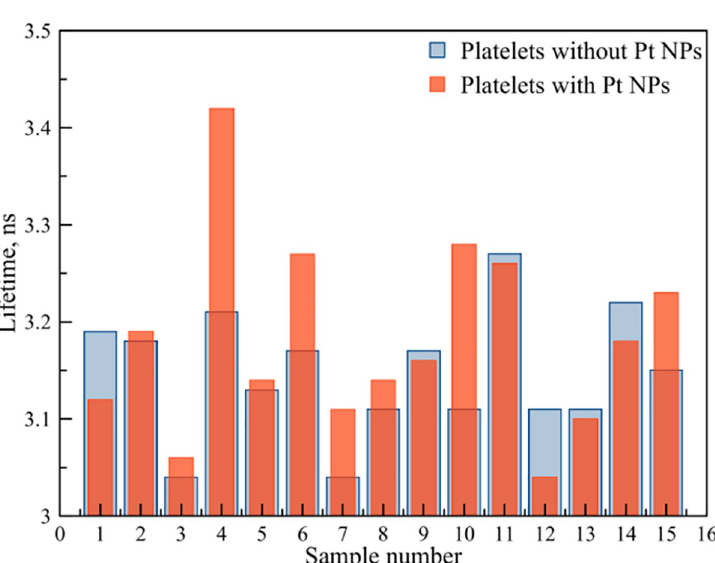
Fig 11. Fluorescence lifetime experimental data for platelet samples without Pt NPs (blue columns) and with Pt NPs (red columns).